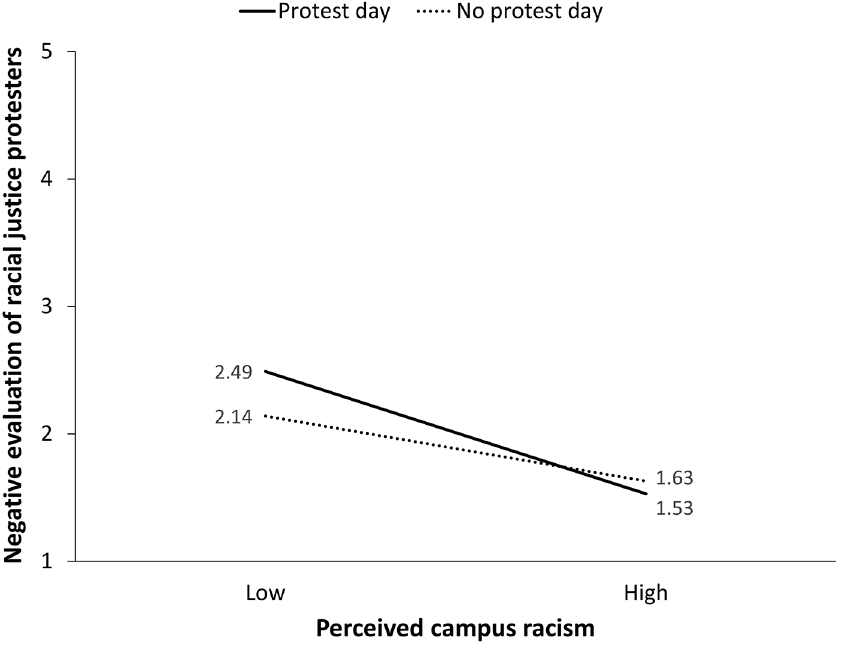
Figure 3. Negative evaluation of racial justice protesters as a function of the interaction between perceived campus racism and condition (protest vs. no-protest